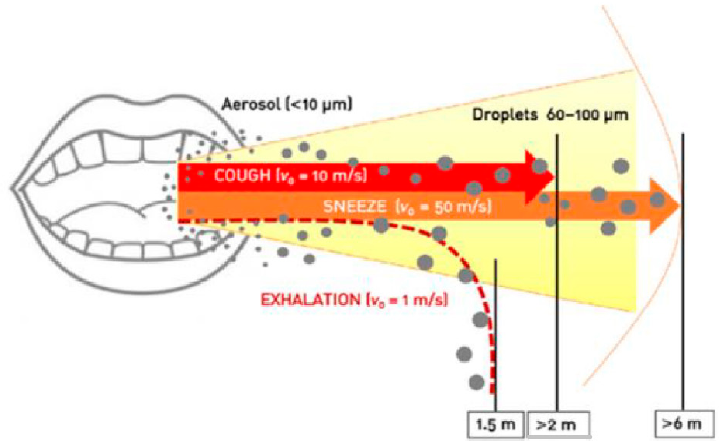
Figure 3. Showing exhalation distances of aerosols and droplets (Reprinted with permission from Ref. [31]. Copyright 2021